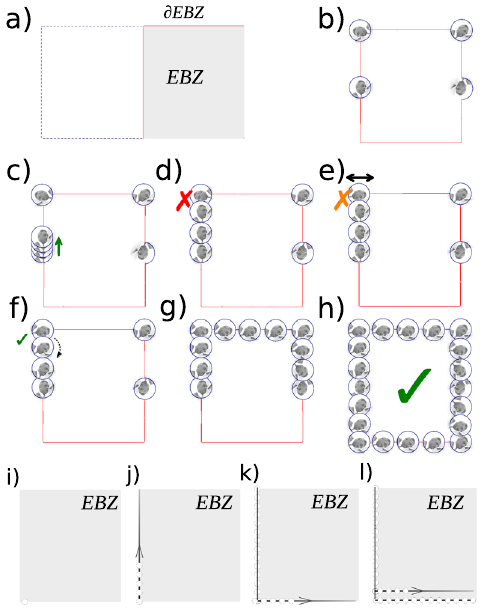
Fig. 2 Schematic overview of the procedure to construct a C 2 and Θ -symmetric gauge along the effective Brillouin zone. The gauge at each point is represented by a portrait of Felix Bloch. The Θ -respecting gauge transformations are rotations of Bloch ’ s C 2 portrait, possibly followed by a re fl ection. a ) Brillouin zone, with in gray the effective Brillouin zone. b ) Selection of C 2 - and Θ -symmetric target Bloch states at the four high-symmetry points within EBZ. c ) A continuous gauge is obtained along the line connecting Γ and Y by parallel transporting the target state at Γ in the direction of Y . d ) Topological mismatch between the parallel-transported states at Y and the target Bloch states at Y . e ) The topological mismatch at Y reduces to a trivial mismatch upon rede fi ning the target states at Y . The rede fi nition is represented as a mirror operation on the portrait of Bloch. f ) The trivial mismatch is removed by a rotation that is evenly spread out over the parallel-transported states along the line connecting Y and Γ . g ) Pictorial representation of continuous C 2 and Θ -symmetric gauge along the upper half of the effective Brillouin zone boundary. h ) Extension of the continuous C 2 - and Θ -symmetric gauge along the entire effective Brillouin zone boundary. i – l ) Procedure to construct a C 2 - and Θ -symmetric gauge in the interior of the EBZ by parallel